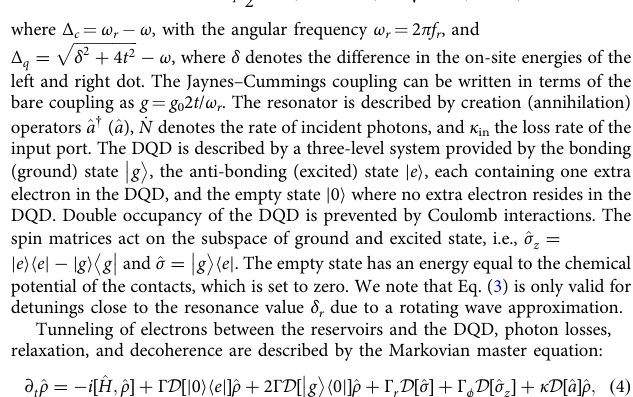
The linewidths and their uncertainty were determined by fi tting a Lorentzian lineshape to the data. The fi ts yield the same